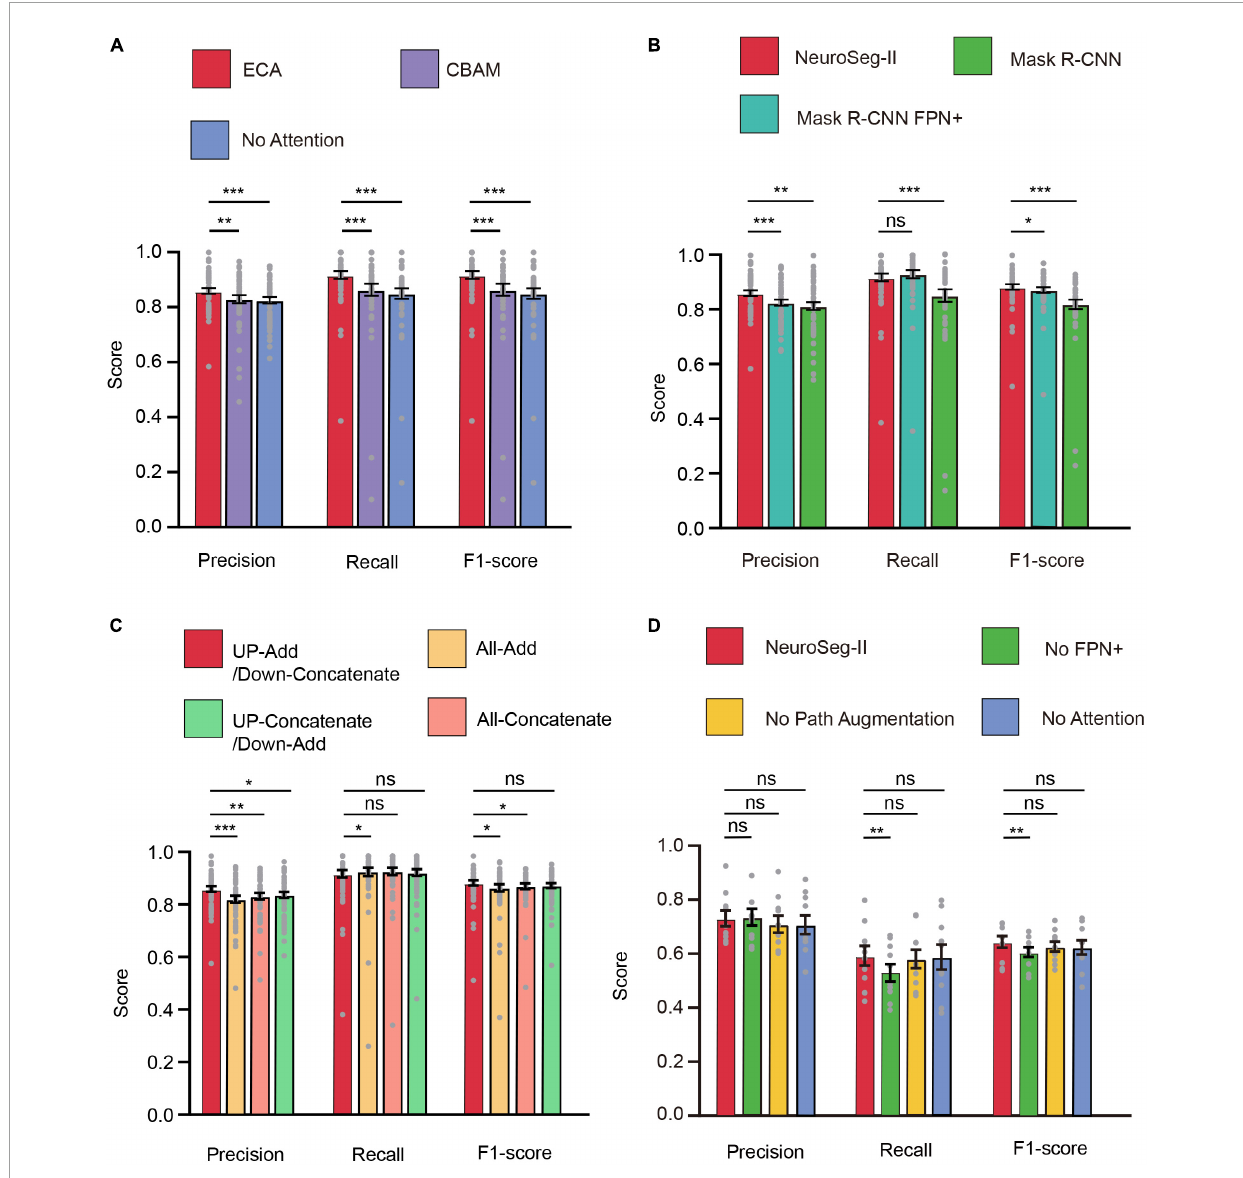
FIGURE5 Attention mechanism, FPN+, and path augmentation increase neuron segmentation accuracy. (A) The efficient channel attention (ECA) module within our model was superior to other approaches for neuron segmentation (** P < 0.01, *** P < 0.001; n = 51 images; and error bars are SEM). (B) NeuroSeg-II’s neuron segmentation score was superior to those of Mask region-based convolutional neural network (R-CNN) and Mask R-CNN FPN+ (adding FPN+ to Mask R-CNN) (* P < 0.05, ** P < 0.01, *** P < 0.001, and n = 51 images; ns, not significant; and error bars are SEM). The results were obtained using hybrid training. (C) The neuron segmentation score of using “Add” for up-sampling and “Concatenate” for down-sampling was superior to those of other methods (* P < 0.05, ** P < 0.01, and *** P < 0.001; n = 51 images; ns, not significant; and error bars are SEM). The results were obtained using hybrid training. (D) The ablation study for testing the network components including attention module, path augmentation and “FPN+” (** P < 0.01; n = 10 images; ns, not significant; and error bars are SEM). The results were obtained using two-round hybrid cross validation with the Neurofinder dataset. All P -values were calculated with a two-sided Wilcoxon signed-rank test. The gray dots represent the scores for each testing